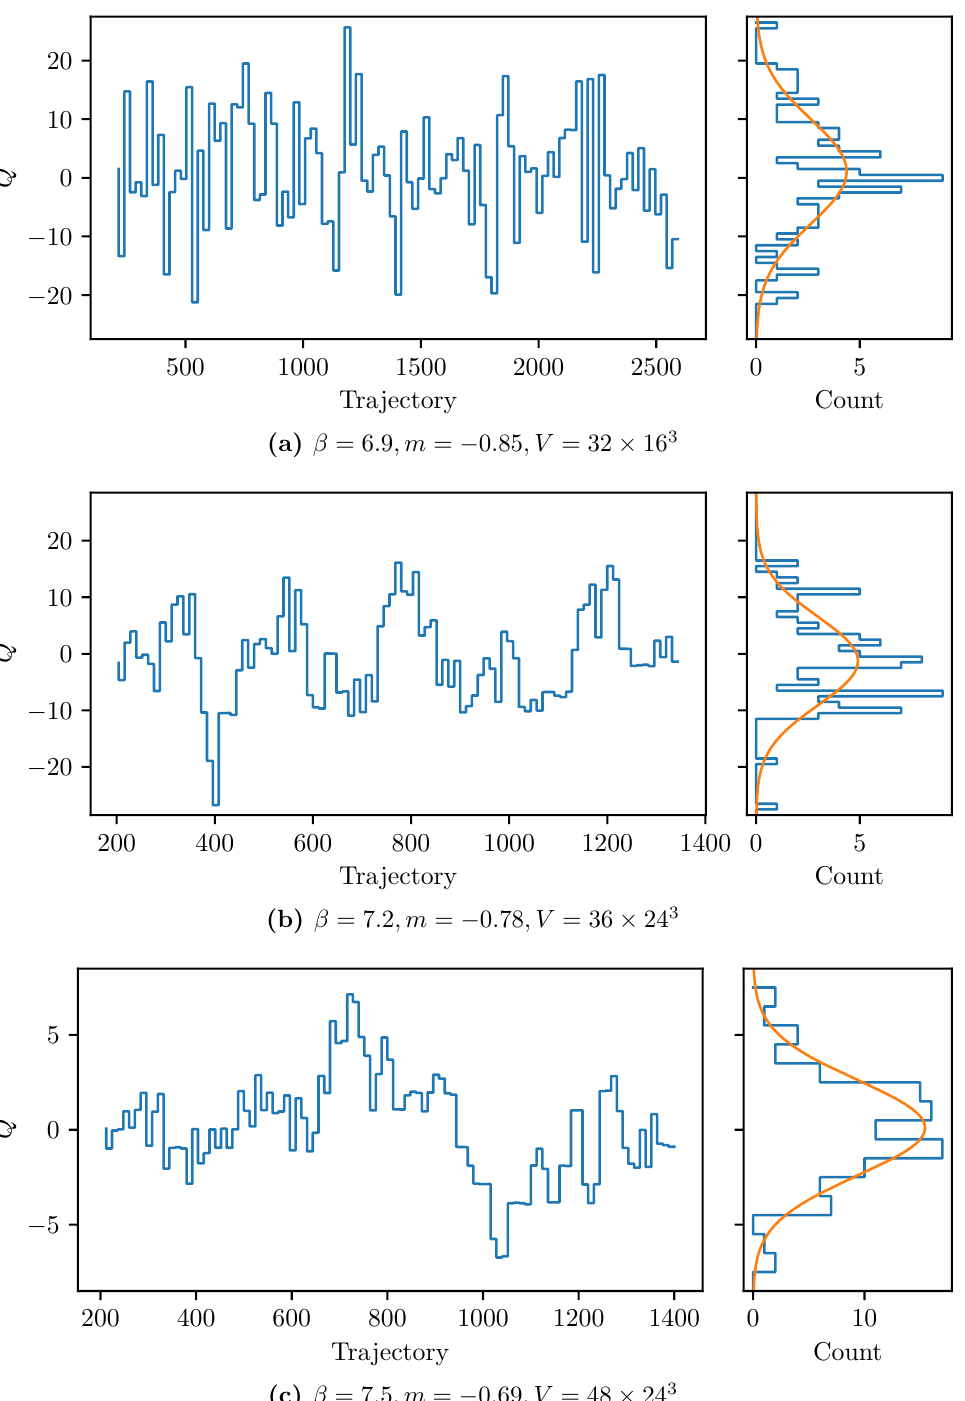
Figure 4. Topological charge histories (left), and histograms (right), for the ensembles DB1M1, DB3M5, and DB5M1, respectively. Fitted parameters are (a) Q 0 = 0 : 02(95), (cid:27) = 8 : 97(96), (cid:28) exp (cid:28) 1; (b) Q 0 = (cid:0) 0 : 48(86), (cid:27) = 7 : 96(86), (cid:28) exp = 1 : 9(7); (c) Q 0 = 0 : 11(24), (cid:27) = 2 : 53(24), (cid:28) exp = 7 :